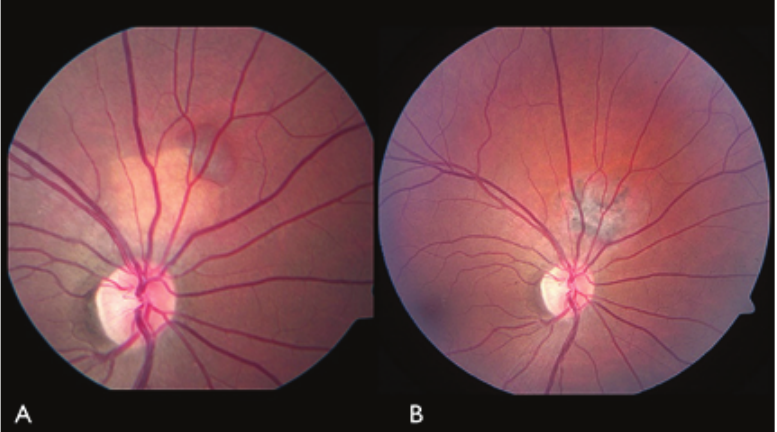
Figure 2. Fundus photograph of the right eye of a patient with juxtapapillary choroidal osteoma associated with subretinal hemorrhage (A) before and (B) after PDT. PDT resulted in complete regression of the tumor and resolution of subretinal hemorrhage.